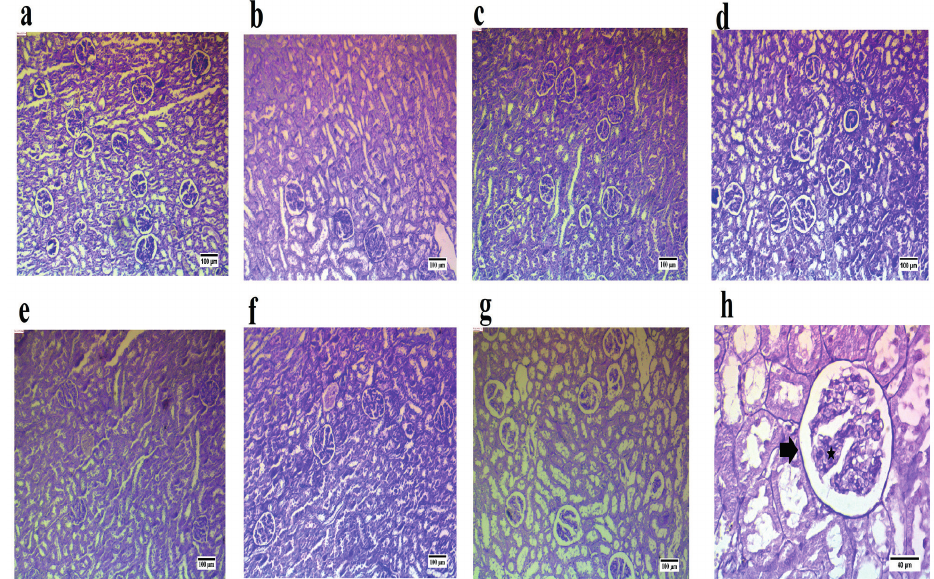
Figure 3 - Evaluation of carbohydrate content in the kidney of rats using PAS staining. Control ( a ), Olive 10% ( b ), Olive 20% ( c ), Cottonseed 10% ( d ), Cottonseed 20% ( e ), Sesame oil 10% ( f ) and Sesame oil 20% ( g , h ). The arrow shows thickening of Bowman’s capsule and the star represents carbohydrate accumulation (PAS-positive) in the glomerulus. Generally, the sections of SES20% group have purple appearance while those from the other groups have blue appearance.